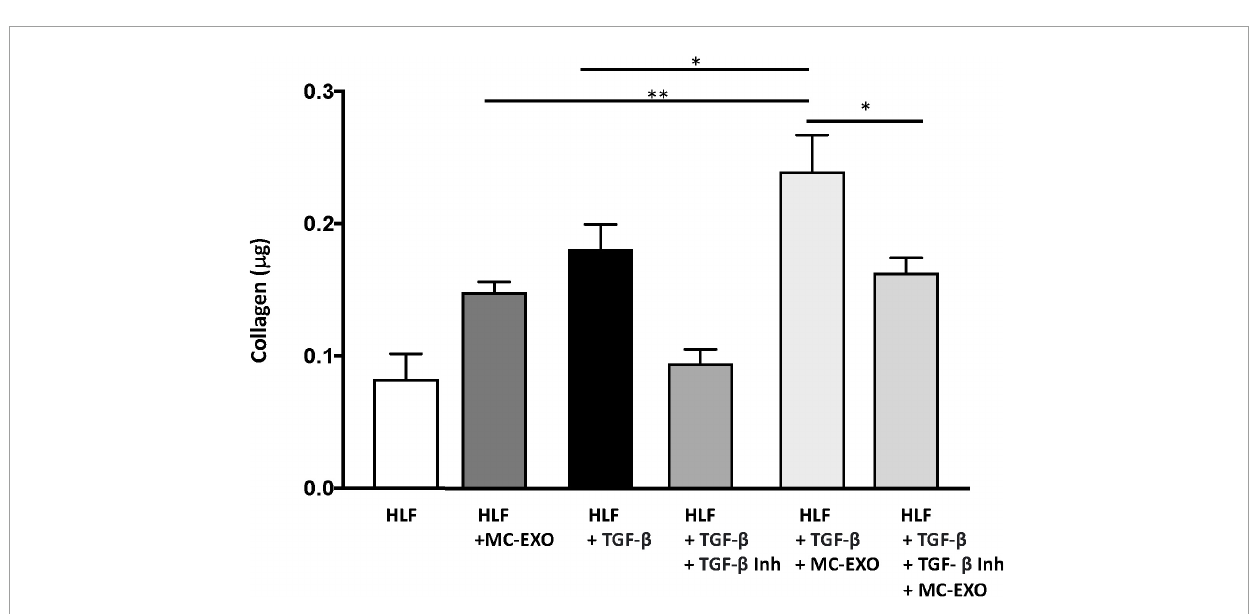
FIGURE4 MC-EXOs and TGF- β have an additive effect on collagen synthesis in HLFs. Secreted collagen measurements in the supernatants of HLF s and HLFs incubated with MC-EXO (40 µ g) or TGF- β (10 ng/ml) with and without the TGF- β R1 inhibitor SB525334 (10 µ M) for 72 h. All assays were performed in triplicate and normalized to total protein ( µ g). ∗ P < 0.05, ∗∗ P < 0.01, n = 5